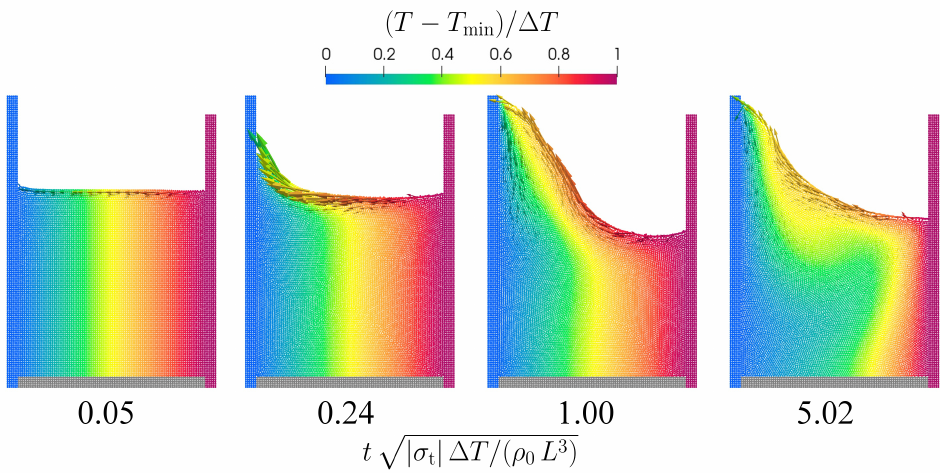
Figure 18. Flow in a basin driven by Marangoni surface current. The normalized temperature is color-coded and the size of the velocity vectors is proportional to the velocity magnitude. The time is normalized by a characteristic Marangoni time